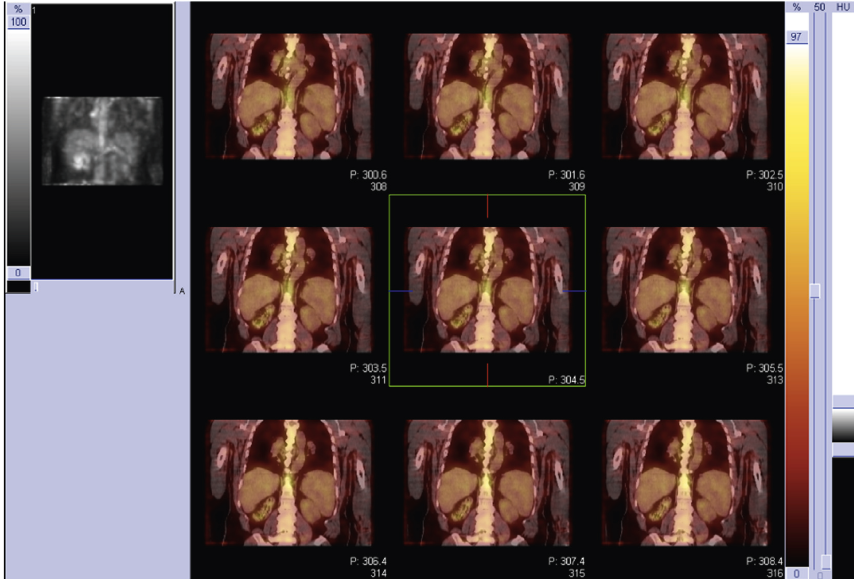
Figure 2: Gallium scan performed two months following completion of IV antibiotics showing intense radiotracer uptake in the right hilum corresponding with a known area of lymphadenopathy suggestive of an active process. No other areas of known lymphadenopathy show increased gallium